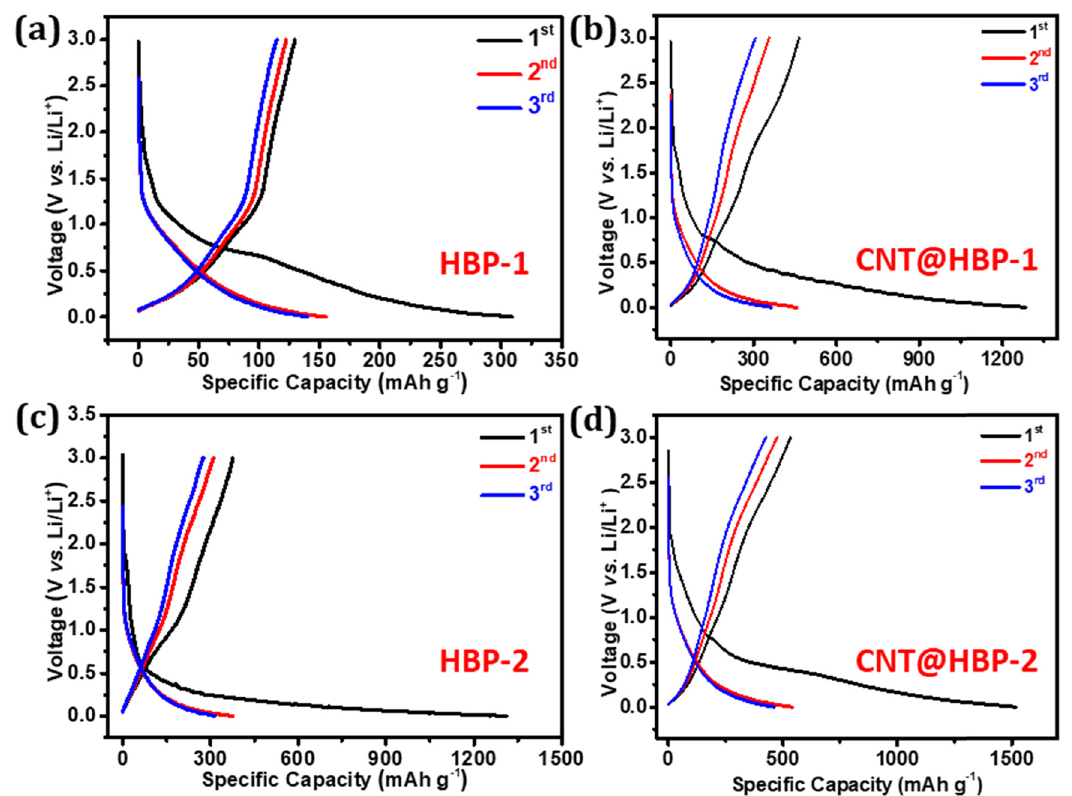
Figure 7: Charge/discharge curves of ( a ) HBP - 1, ( b ) CNT@HBP - 1, ( c ) HBP - 2, and ( d ) CNT@HBP - 2 at a current density of 0.1 A g − 1 in the fi rst three cycles.